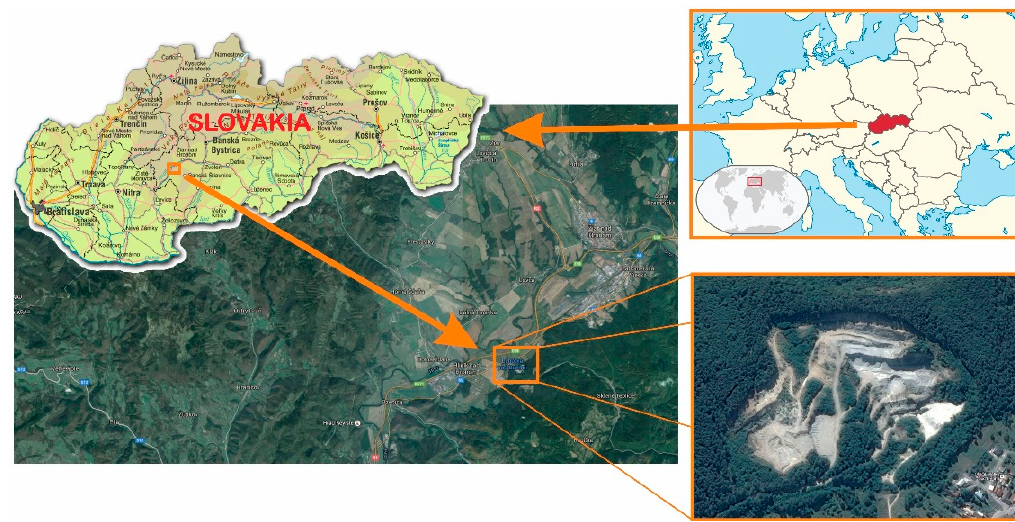
Figure 1. Location of the perlite deposit Lehôtka pod Brehmi (Slovakia).